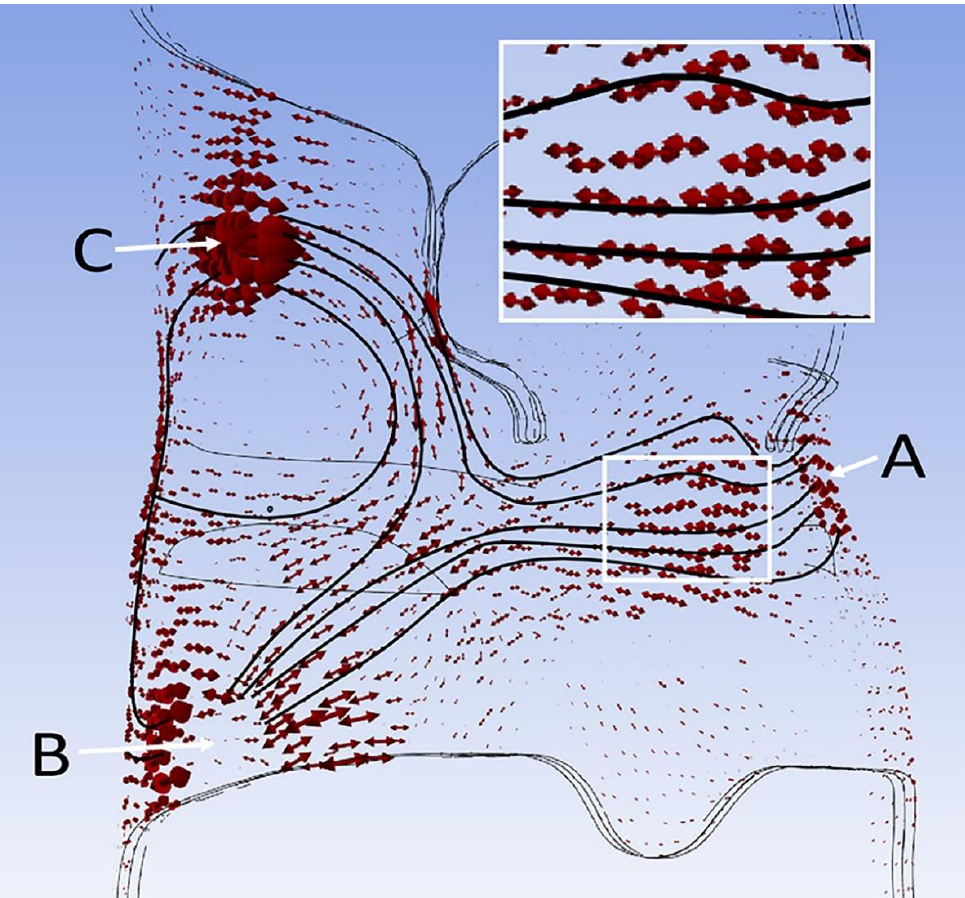
Figure 9. Principal tensile stress vector distribution with plotted trajectories of principal stress. Places where forces are applied: A and C − forces acting on the thoracic cage, B − force applied to the pelvis.